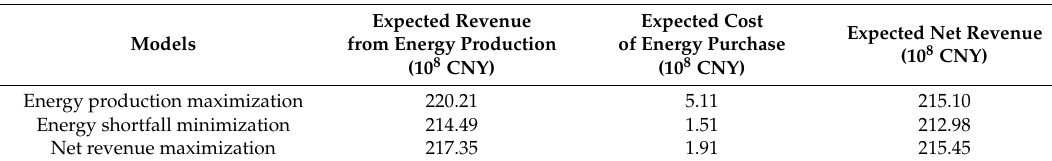
Table 4. Statistics of results from different models under a high value of λ .